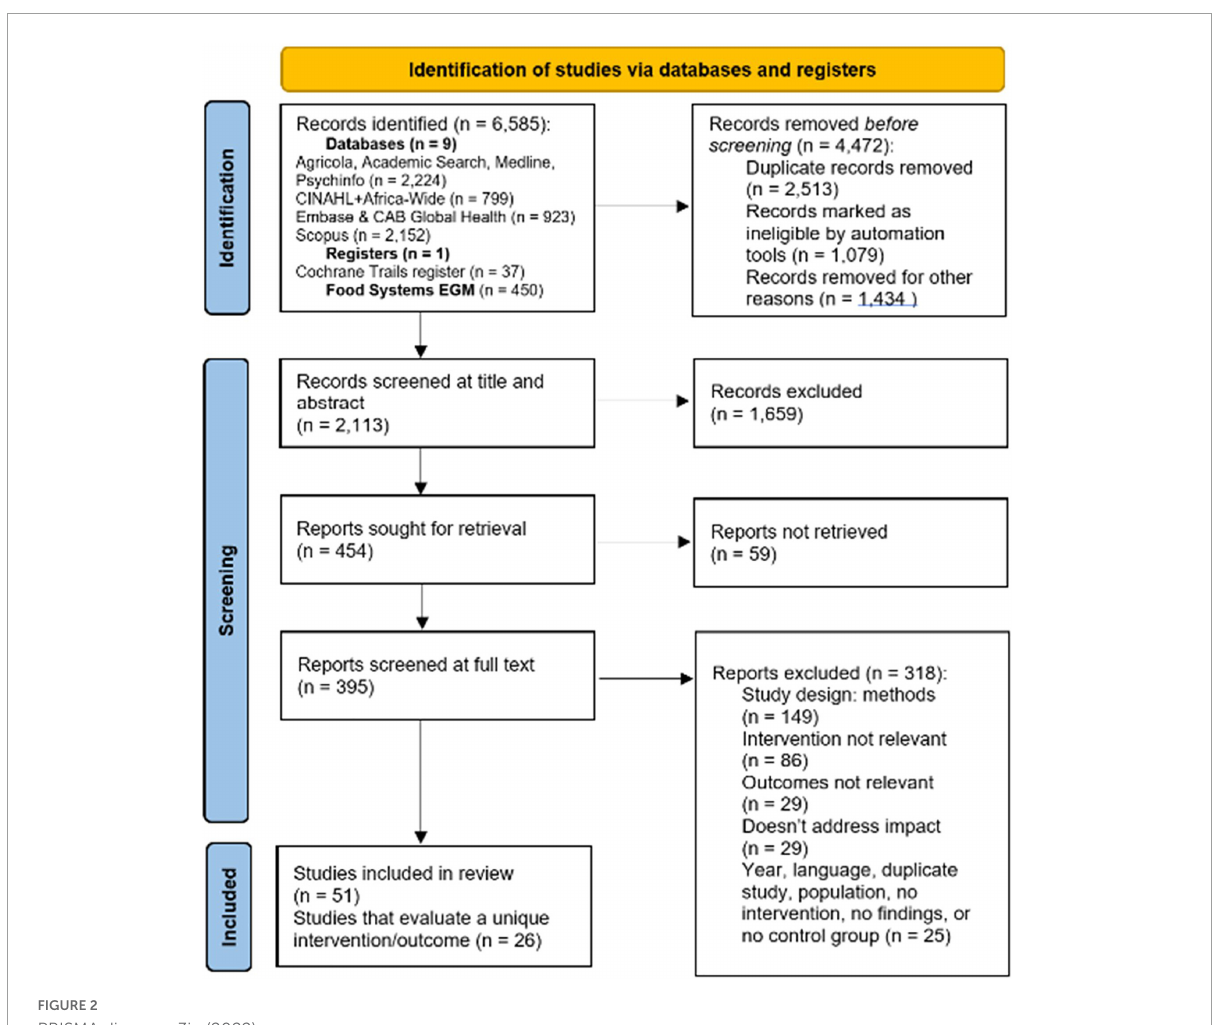
FIGURE2 PRISMA diagram, 3ie